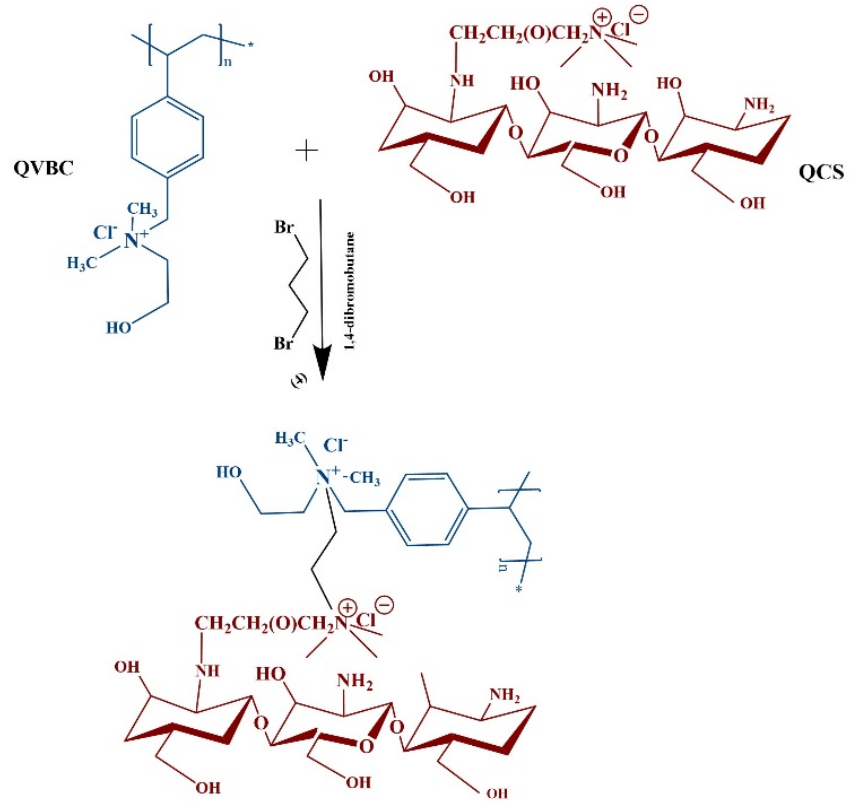
Figure 4. Crosslinking and membrane formation.